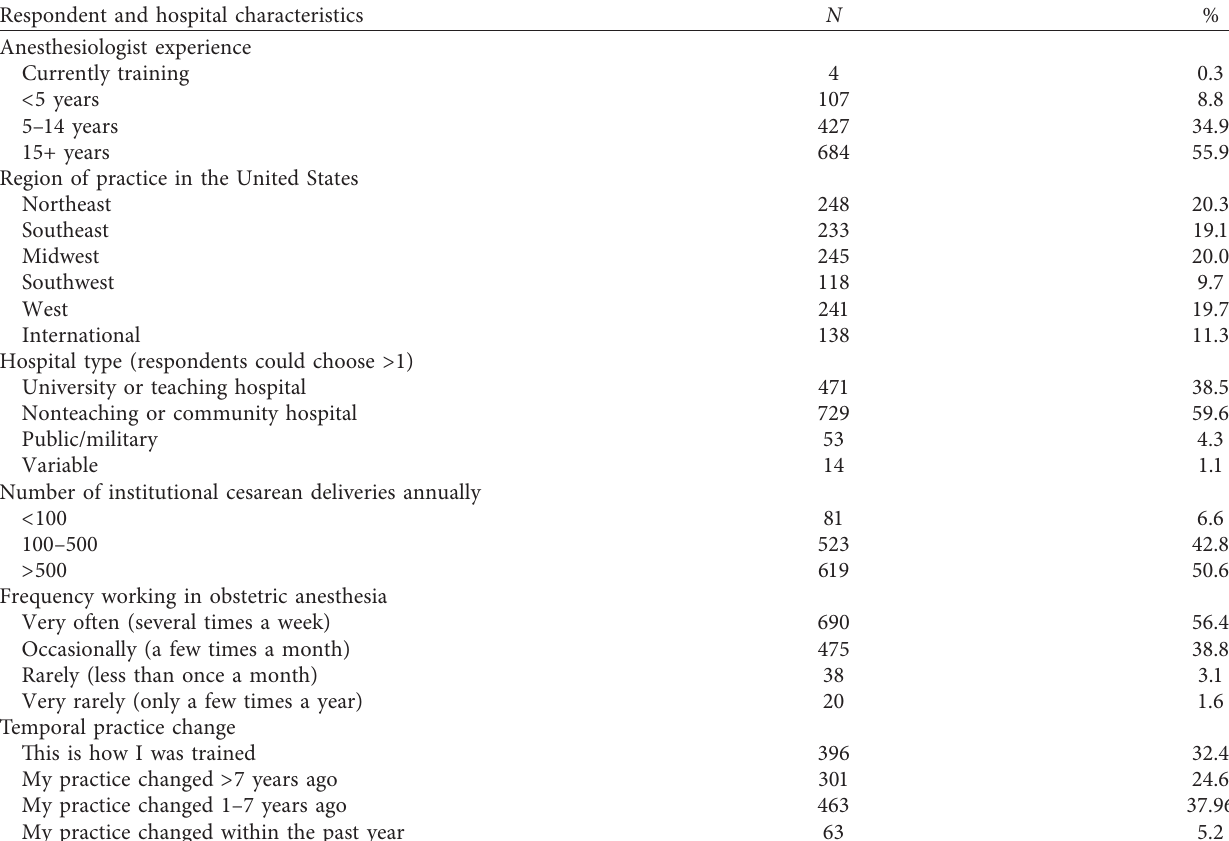
Table 1: Baseline characteristics of survey